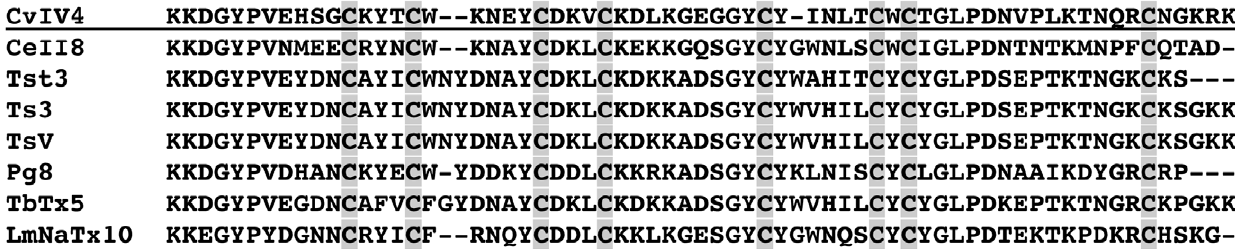
Figure 5. Comparison of CvIV4 translated cDNA with Na + channel toxin sequence from other scorpion species. CvIV4 (underlined) is aligned with seven toxin sequences from other species. Alignment is based on cysteine residue position (shaded background) and toxins are arranged in order of descending percent identity with respect to CvIV4. Percent identify (%ID) is estimated from the number of amino acids shared by two toxins (NCBI Protein BLAST). While CvIV4 (JF938594) and CeII8 (P0CH40) are structurally similar (64% ID), they are functionally different as CvIV4 is classified as an a -toxin and CeII8 as a b -toxin (classification based on electrophysiological recordings from Na + channel subtypes). CvIV4 shares over 50% of its amino acid residues with the remaining six toxins. Ts3 (P01496) and TsV (P46115) are classified as a -toxins based on electrophysiological studies of mammalian cells and tissues. Tst3 (P0C8X5), Pg8 (ACD35698), TbTx5 (P0C5K8) and LmNaTx10 (ACD35698) are classifed as a -toxins based solely on sequence similarity. Cv= Centruroides vittatus , Ce= Centruroides elegans , Tst= Tityus stigmurus , Ts= Tityus serrulatus , Pg= Parabuthus granulatus , Tb= Tityus bahaensis , Lm= Lychas mucronatus . GenBank accession numbers are shown in parentheses following the toxin name.